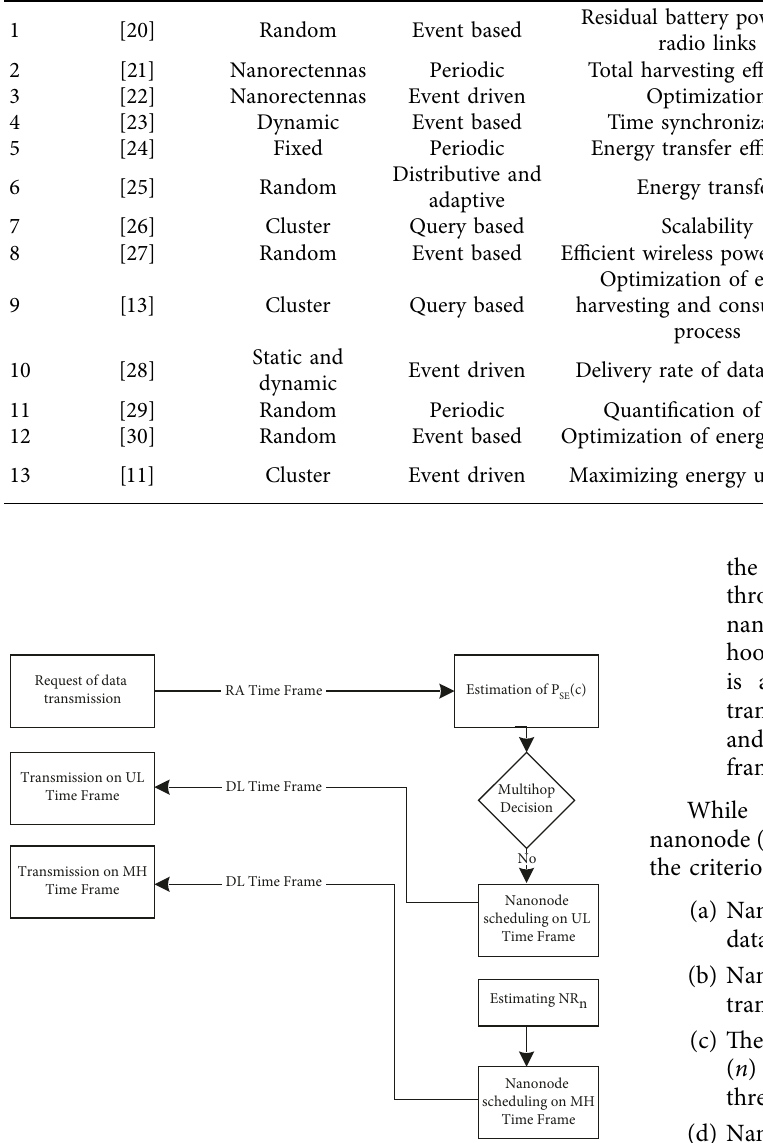
Figure 1: Stages of multihop transmission decision